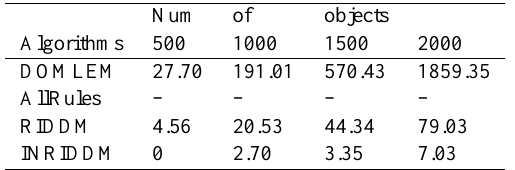
Table 5. The running time(in seconds) of all algorithms worked in mushroom .